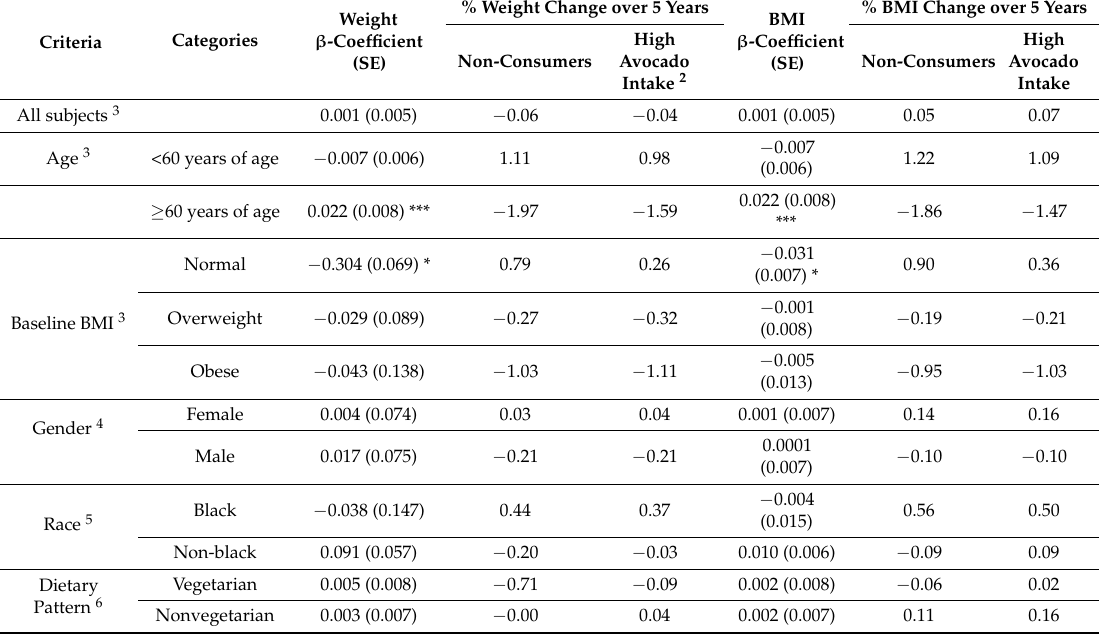
Table 3. Effect of avocado intake on change in weight and BMI over time in Adventist Health Study-2 cohort 1